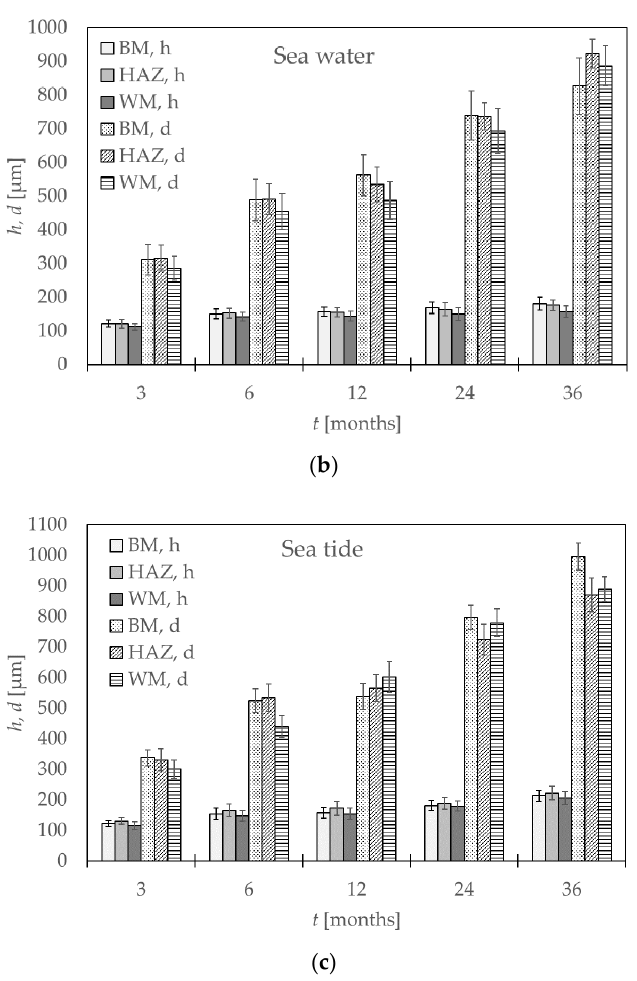
Figure 7. Values of average pit depth ( h ) and pit diameter ( d ) of specimens over exposed time ( t ). ( a ) water, ( b ) sea water, ( c ) sea tide.